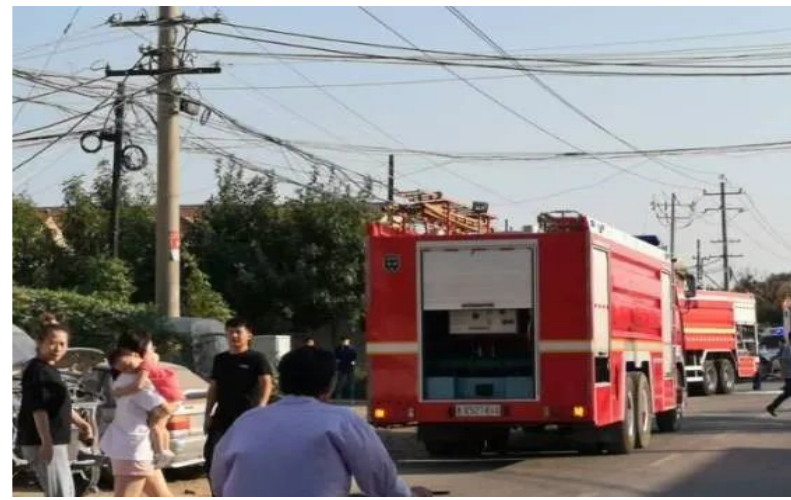
Figure 7. Emergency rescue teams: rescue medical staff (picture source: [22]).